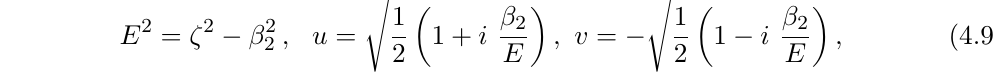
Figure 4 . Complexity for the effective wave function when both oscillators are inverted (left panel) and when one of the oscillators are inverted. The parameters are — Left: (cid:15) (cid:15) 2 = − 5 , λ = 0 . 1 and Right: black dashed curve has (cid:15) 1 = 5 . 01 , (cid:15) 2 = − 5 , λ = 0 . 1 and the blue curve has (cid:15) = − 5 . 01 , (cid:15) = 5 , λ = 0 . 1 1 2